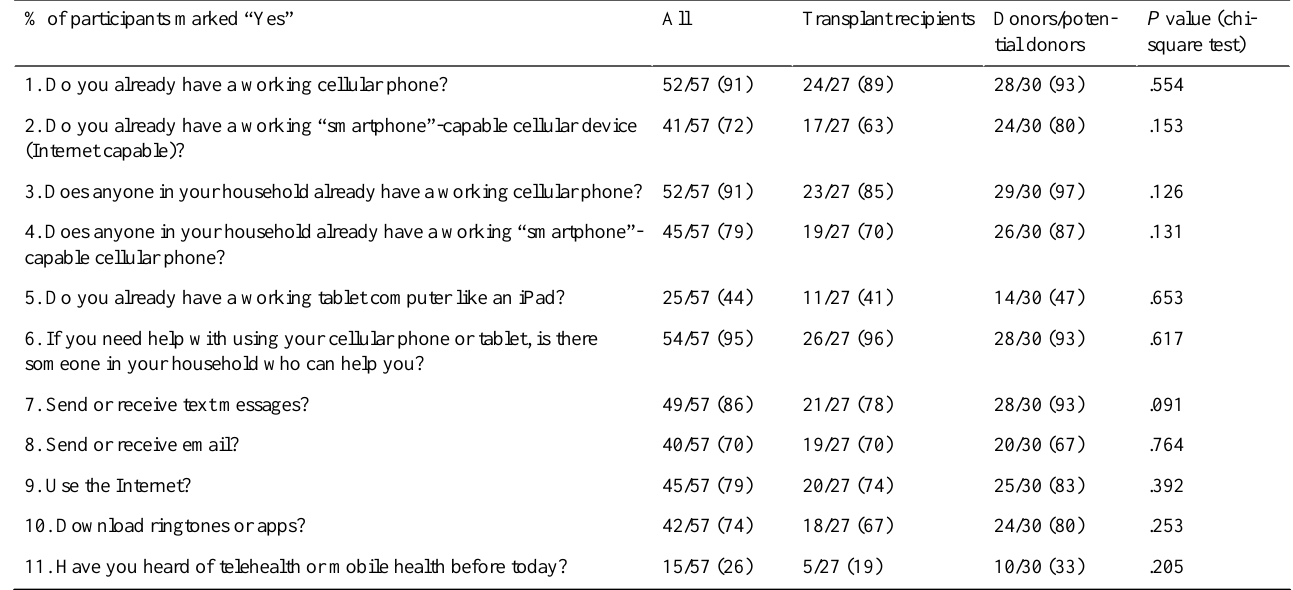
Table 2. Cellular technology-use questions delivered by questionnaire or read-out loud.